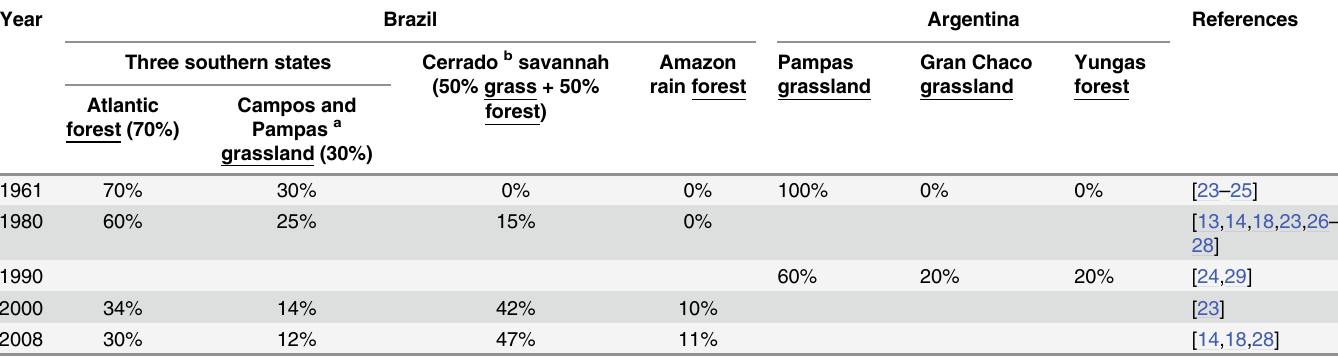
Table 1. Overview of the relative distribution of soybean area expansion in different regions of Brazil and